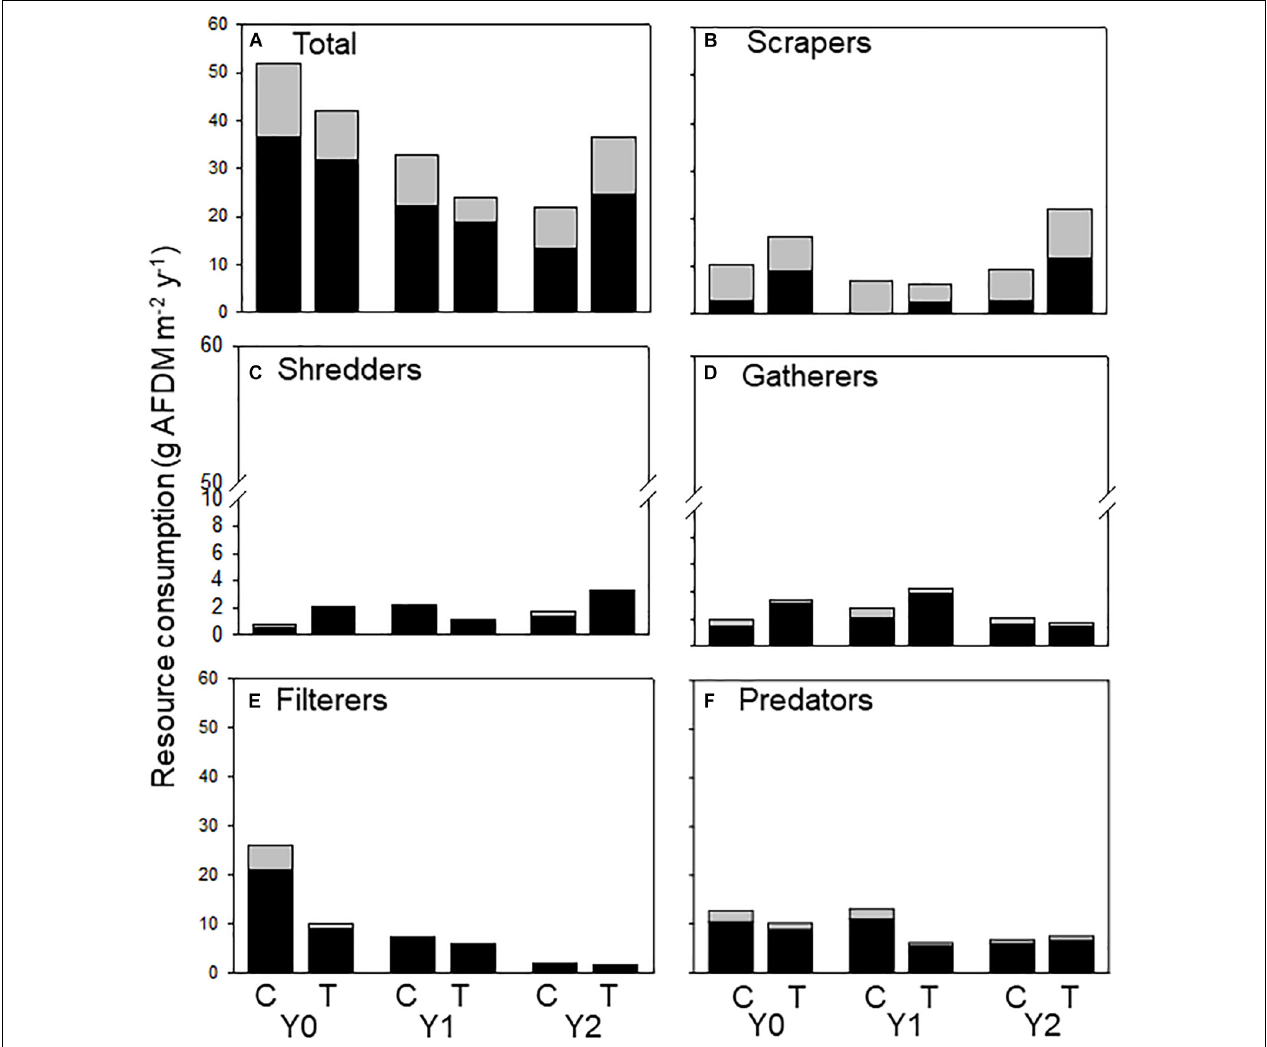
FIGURE 5 | Allochthonous (dark bars) and autochthonous (light bars) C consumed by macroinvertebrates (categorized by functional feeding groups) in an upstream control C and downstream wood-added reach (treatment, T) 1 year before (Y0) and 1 (Y1) and 2 years (Y2) after wood addition. (A) Represents all macroinvertebrate consumption, (B) represents scraper consumption, (C) represents shredder consumption, (D) represents gatherer consumption, (E) represents filterer consumption and (F) represents predator consumption of allochthonous and authochonous